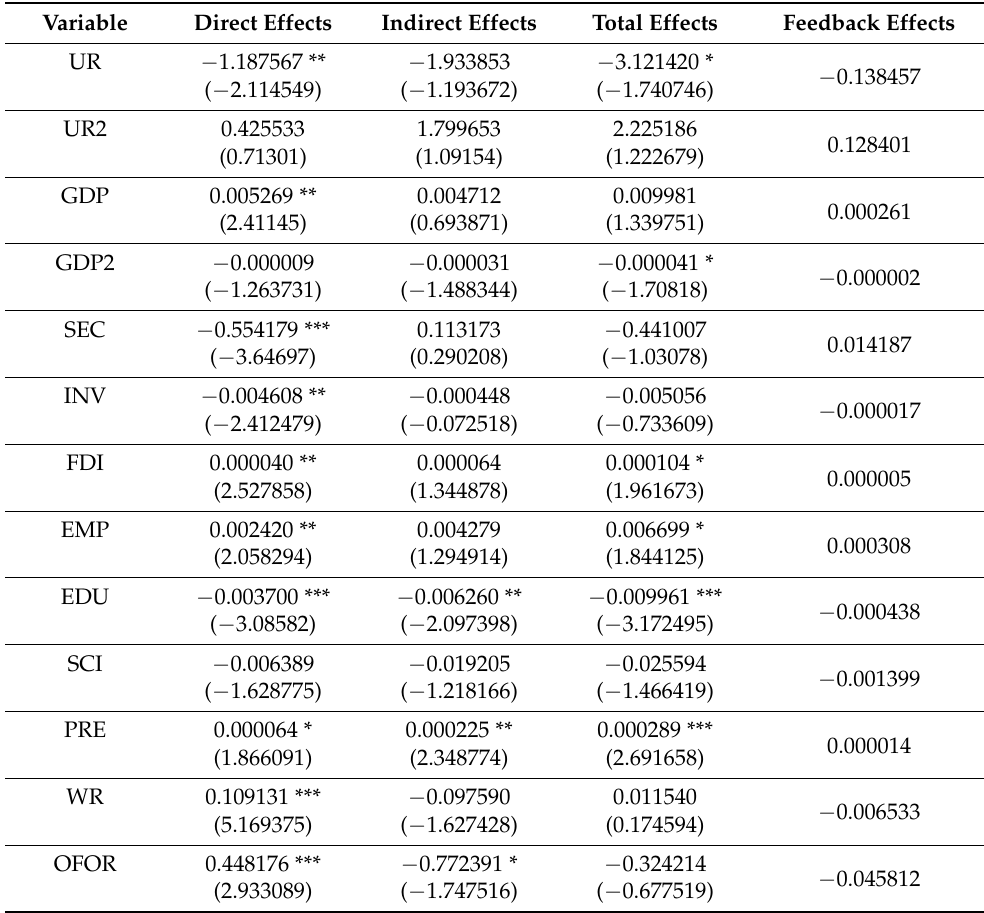
Table 4. Results of direct, indirect, total, and feedback